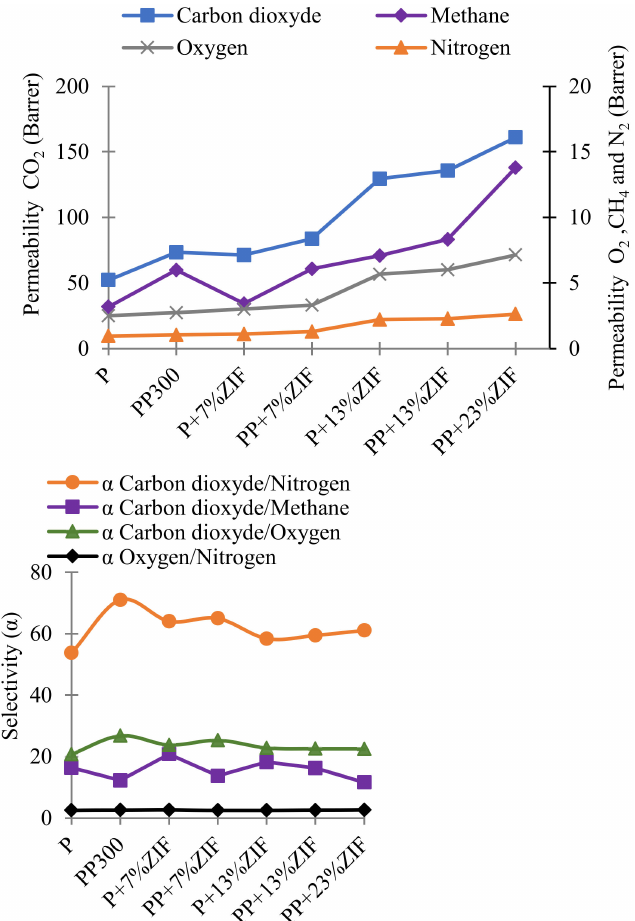
Figure 9. Permeability and selectivity coefficients for neat Pebax, Pebax/ZIF-8 and Pebax/PEG/ZIF-8 blend